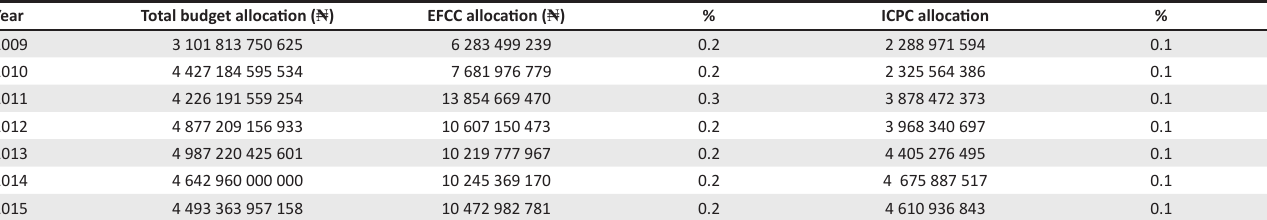
TABLE 2: The economic and financial crimes commission and the Independent Corrupt Practices and Other Related Offences Commission and their percentages of the total amount budgeted. Year Total budget allocation ( ₦